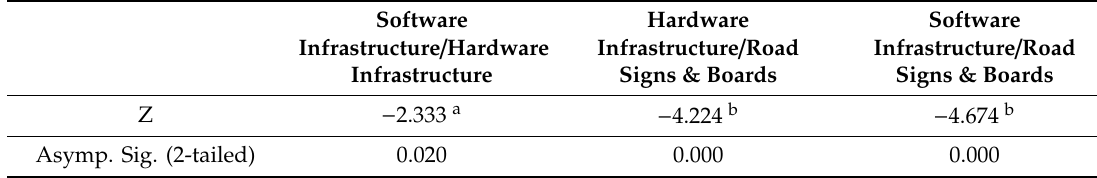
Table 13. Wilcoxon sign test (statistics) for critical investments required to facilitate AV.